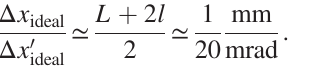
. The red curve (analytic) ref